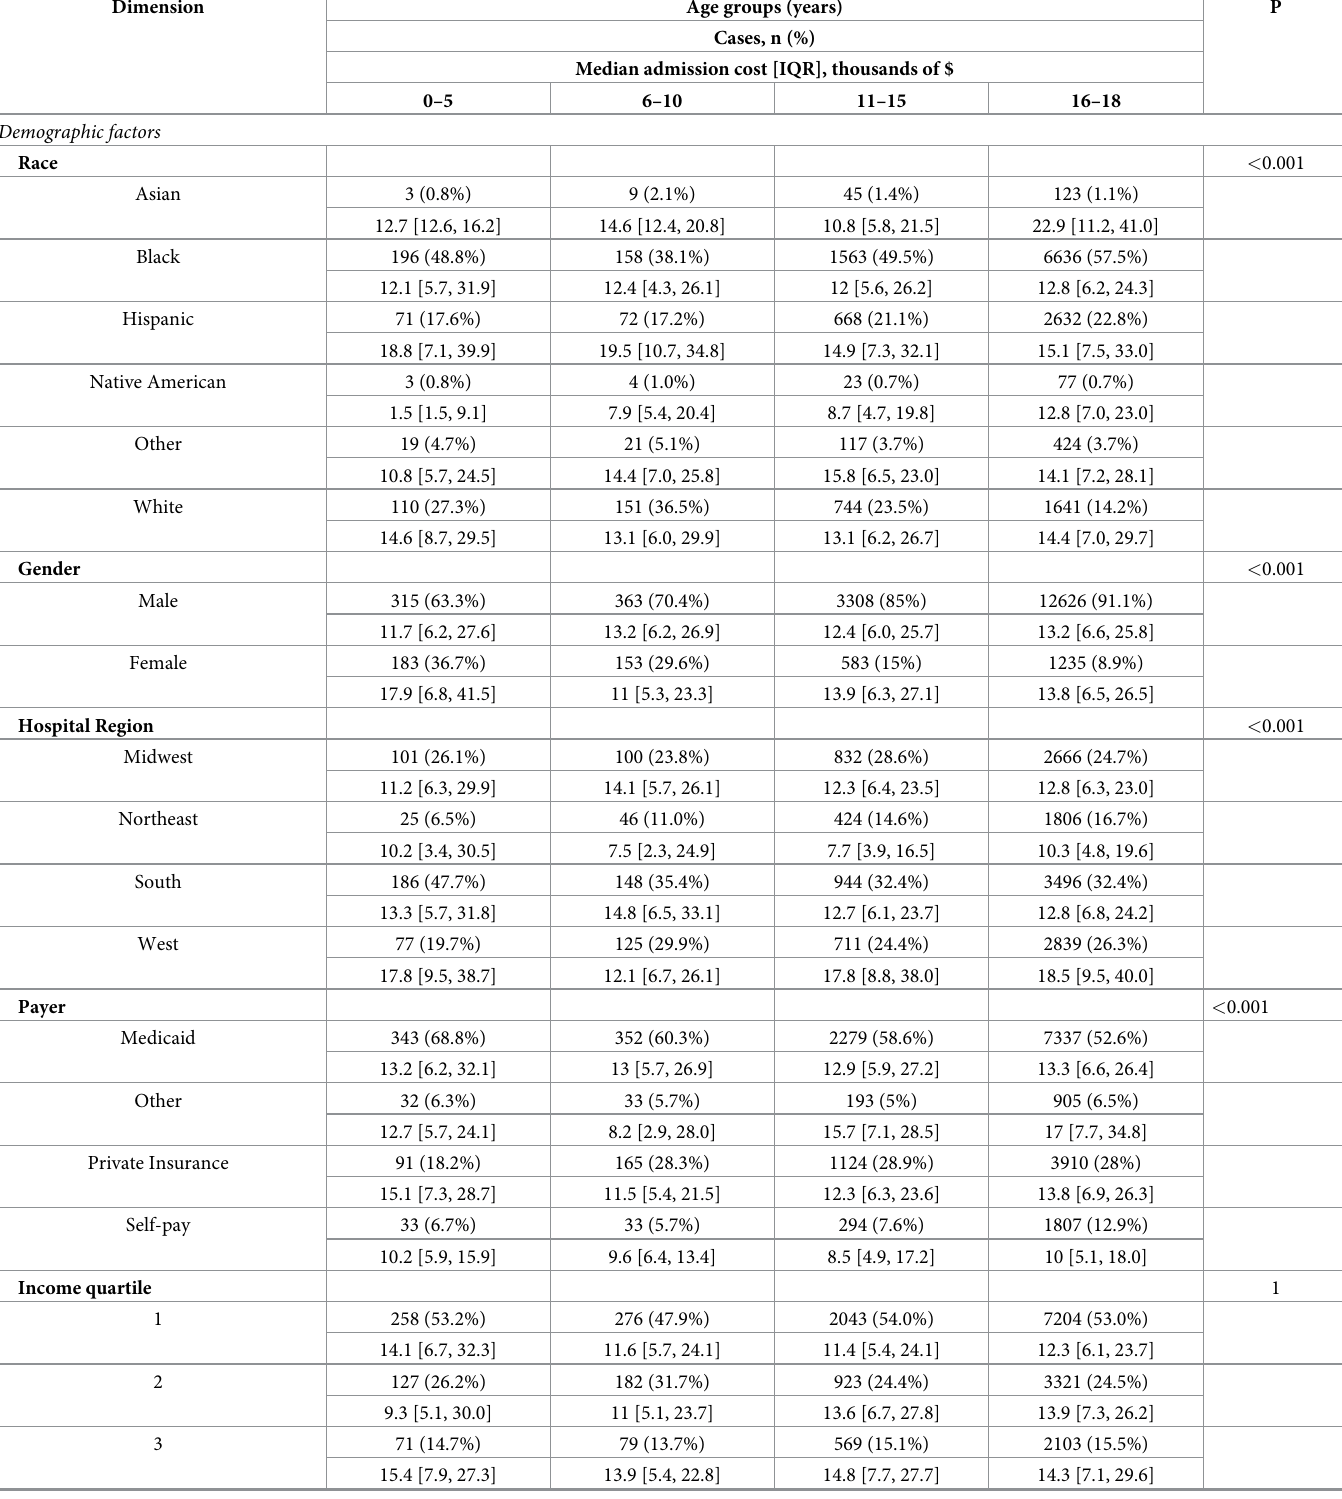
Table 2. Incidence and median cost of firearm hospitalizations in the U.S. by age (2003, 2006, 2009,